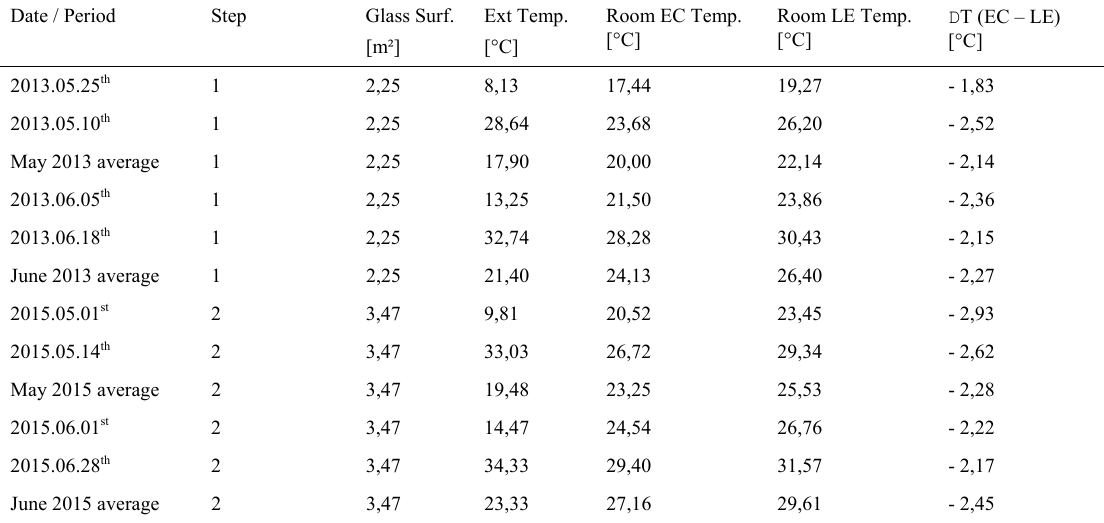
Table 1: Comparison Step 1 to Step 2 in the days in which the lowest and the highest averages were during the period in